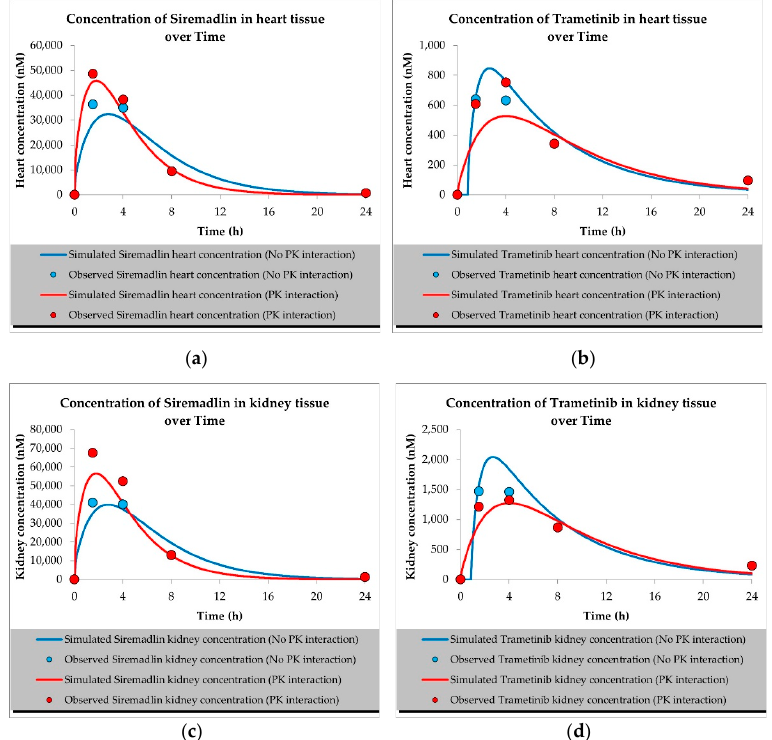
Figure 4. Values of predicted concentrations with and without PK interaction for ( a ) siremadlin and ( b ) trametinib in heart tissue; ( c ) siremadlin and ( d ) trametinib in kidney tissue; observed data are means from n = 3.